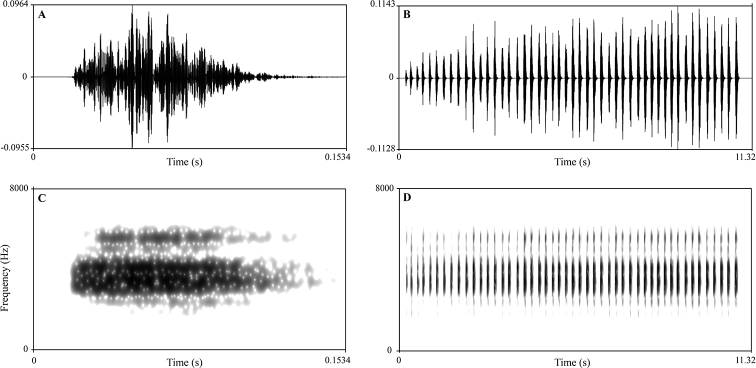
Advertisement call of the holotype CIBXJ190503 of Megophrys
xianjuensis sp. nov. A waveform showing one note B waveform showing three notes of one advertisement call C sonogram showing one note D sonogram showing three notes of one call.